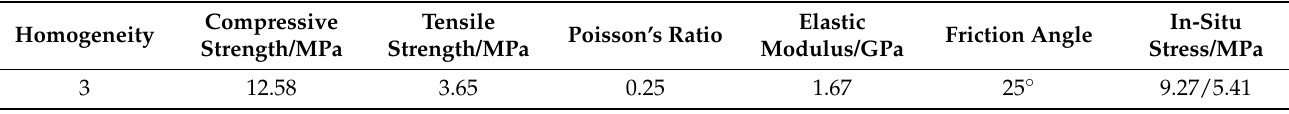
Figure 11. Numerical calculation model of different hole spacings. Table 1. Mechanical parameters of gangue layer in working face 42108.